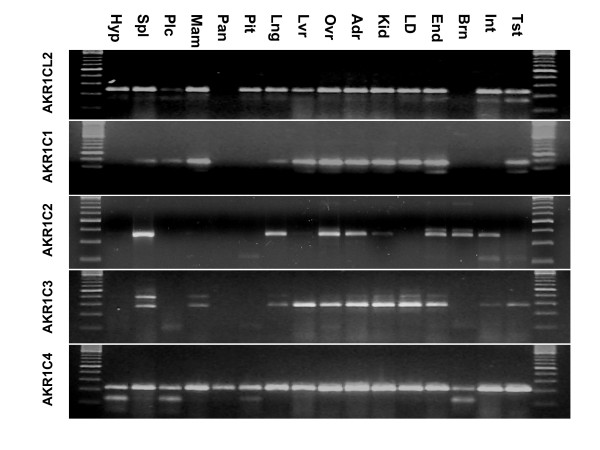
RT-PCR amplification of pig AKR1C genes in different tissues from a purebred Meishan sow at day 25 of gestation and mature testis using gene-specific primers (Hyp, hypothalamus; Spl, spleen; Plc, placenta; Mam, mammary tissue; Pan, pancreas; Pit, pituitary; Lng, lung; Lvr, liver; Ovr, ovary; Adr, adrenal; Kid, kidney; LD, longissimus dorsi muscle; End, endometrium; Brn, brain; Int, small intestine; Tst, testis). Amplicon sizes are given in Table 1; marker is a 100 bp ladder.